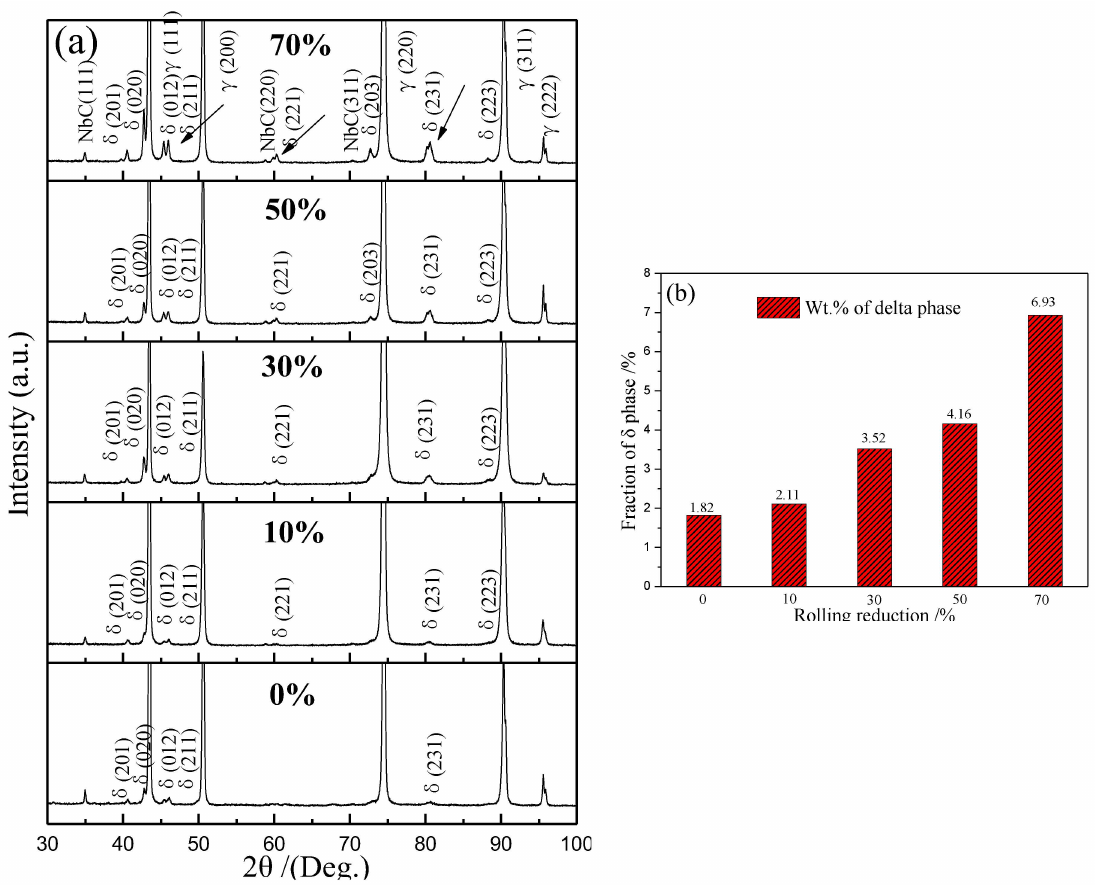
Figure 3. Diffraction patterns and phase fractions after solid solution under different cold rolling reduction ( a ) Diffraction patterns ( b ) Phase